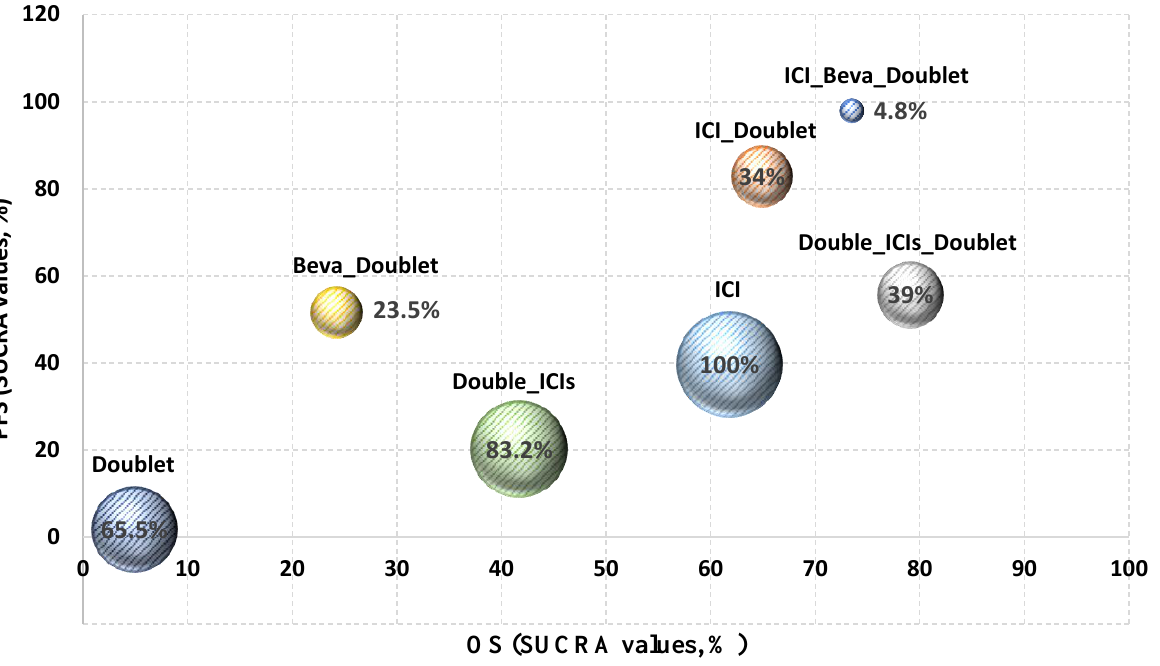
Figure 5. Scatter plot for efficacy and safety based on the SUCRA values (%). The size of each circle is weighted by the SUCRA values of Grade 3–5 AEs. Abbreviations: Beva: bevacizumab; ICI: immune checkpoint inhibitor; Doublet: doublet chemotherapy; SUCRA: surface under the cumulative ranking curve.